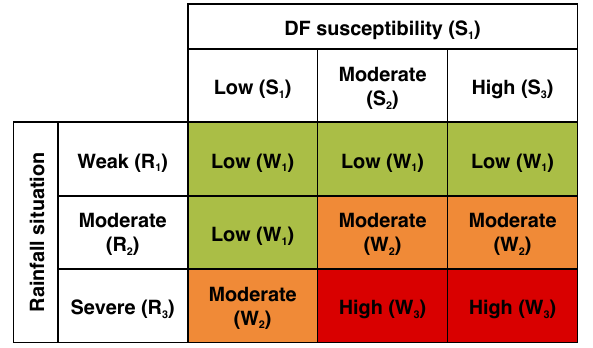
Figure 10. Rule used to derive the DF warning level from the com- bination of subbasin DF susceptibility and the magnitude of the rainfall